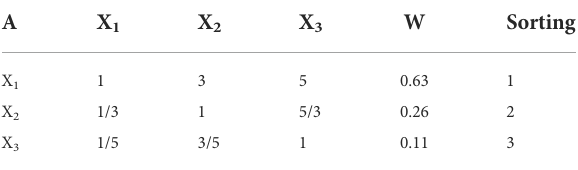
TABLE 6 The land utilization factors sorting and weight reference